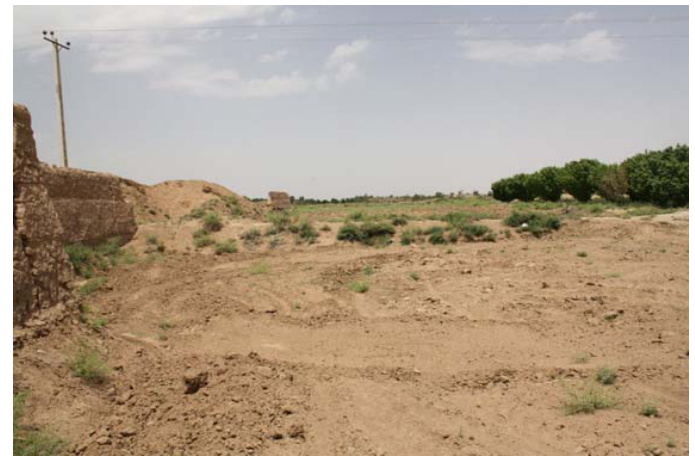
F IGURE 3. Habitat of Ophiomorus nuchalis (the specimen ZMGU.2580). T ABLE 1. Measurements of Ophiomorus nuchalis from Iran.